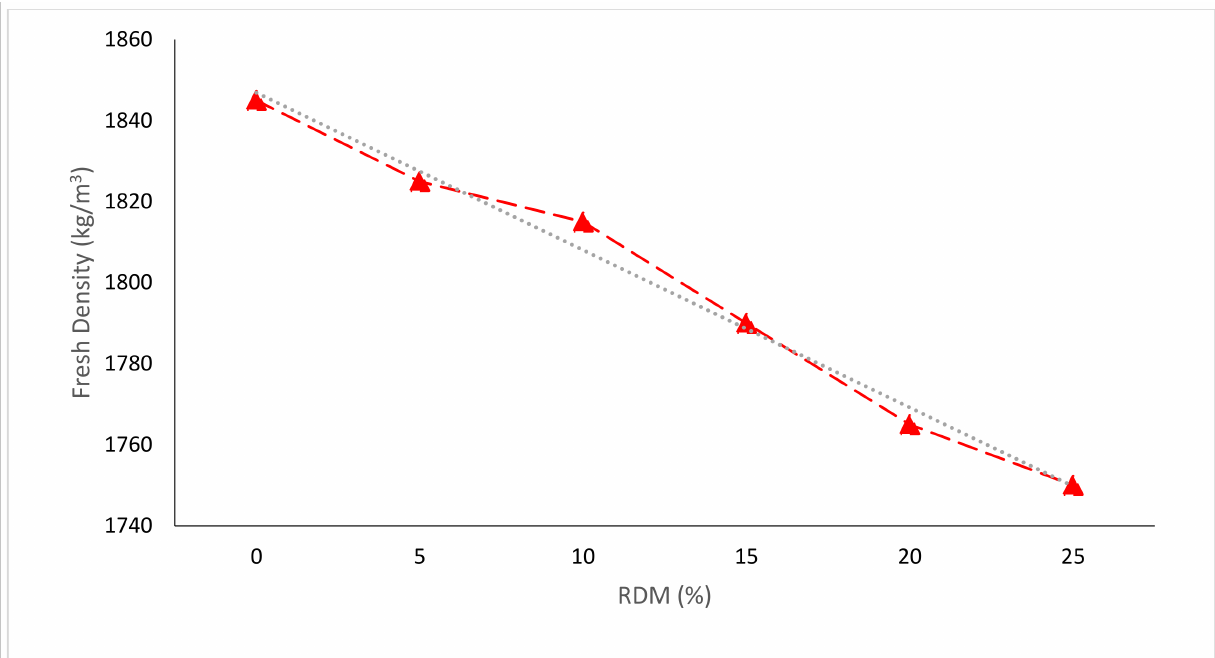
Figure 7. Fresh Density: Data Source [40].